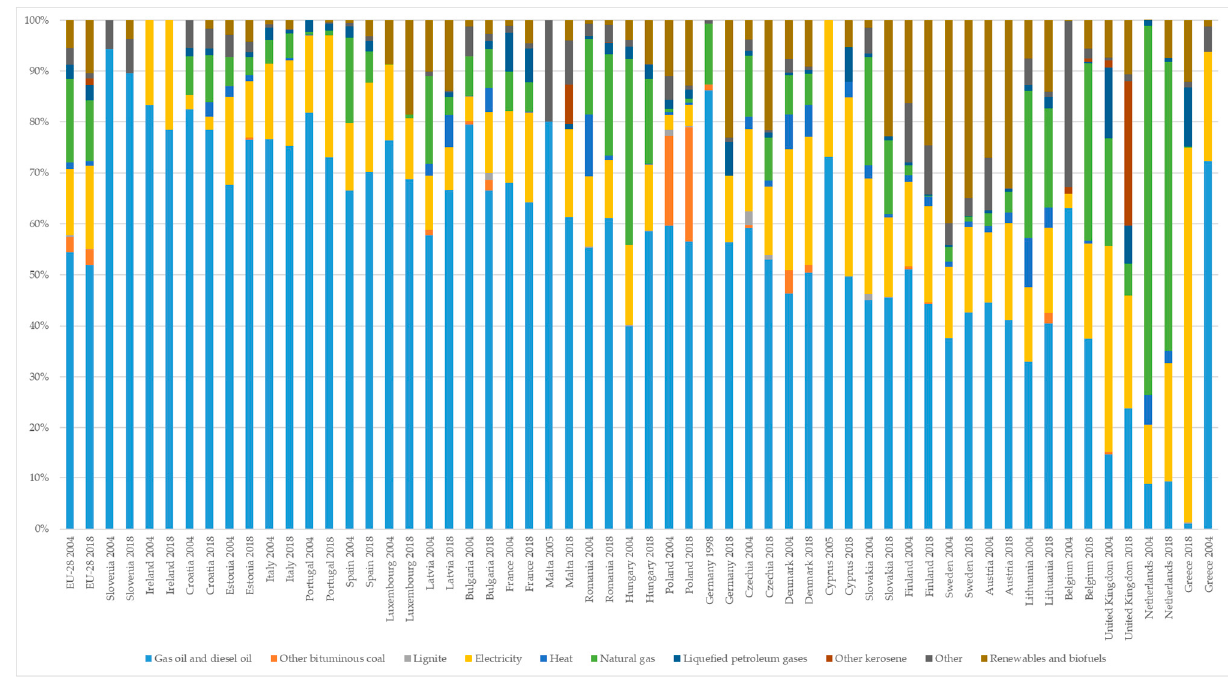
Figure 3. The structure of energy consumption in agriculture in the EU countries in 2004–2018. Reproduced from [44], Eurostat: 2021.